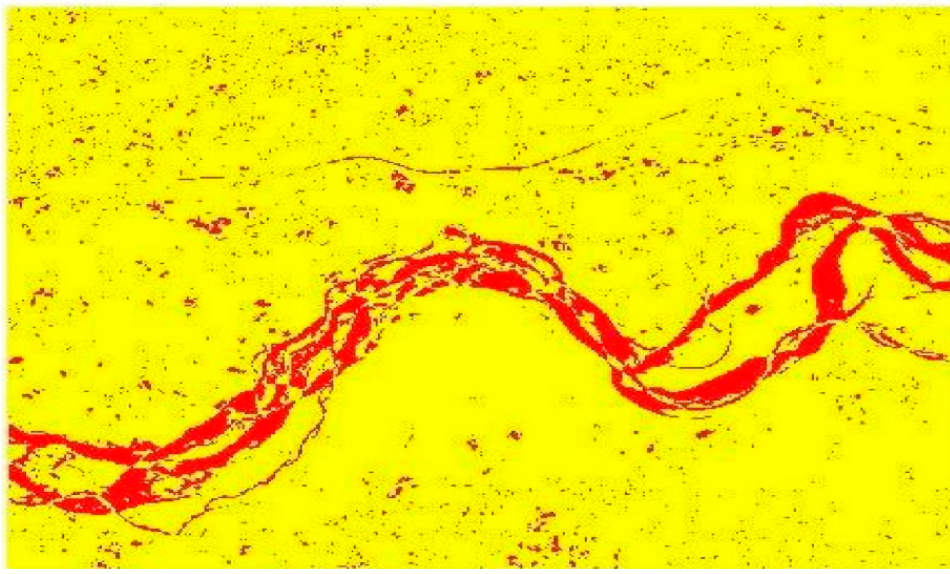
Figure 9. Result of image